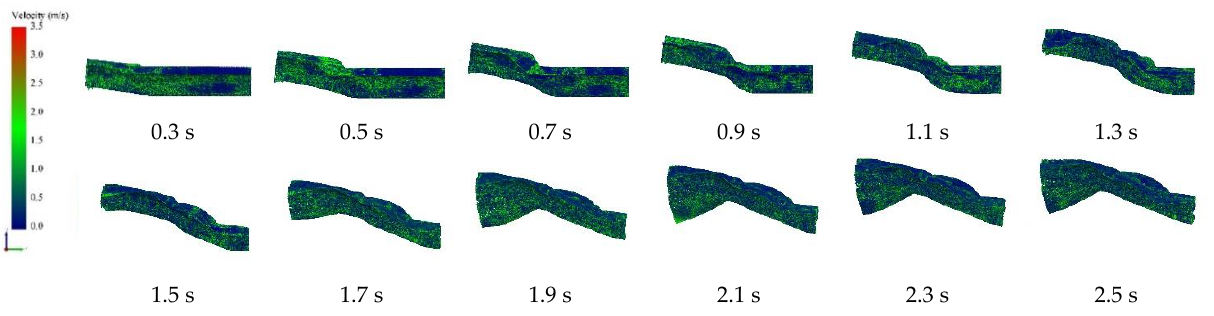
Figure 8. Film shapes at different times under the action of the third-order shovel film-lifting